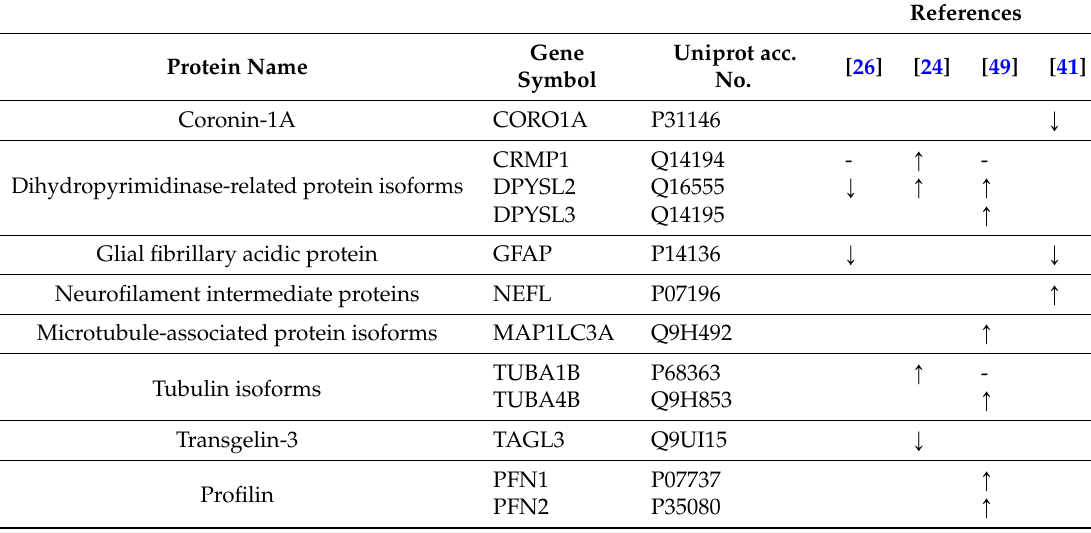
Table 2. Summary of the proteins altered expression from postmortem proteomic investigations of major depressive disorder. Downregulated ( Ó ), upregulated ( Ò